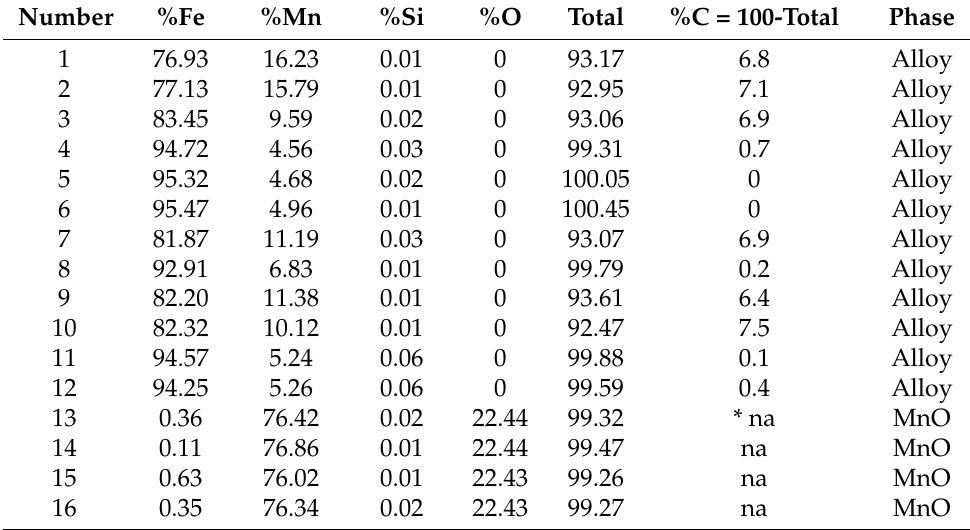
Table 4. SEM-WDS analyses of points in Figure